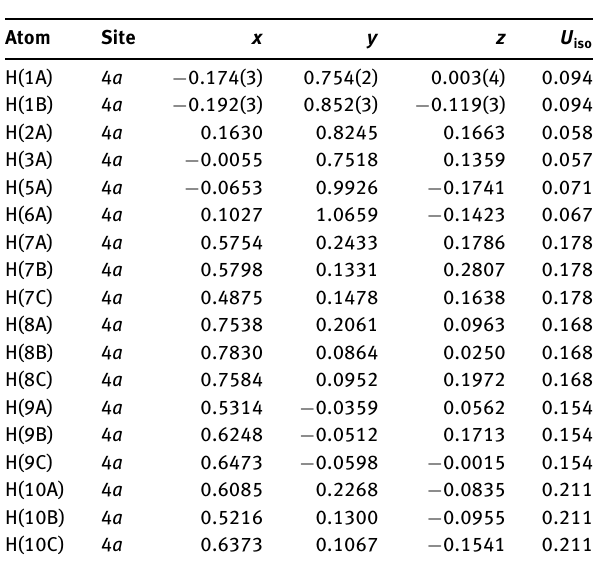
Table 2: Fractional atomic coordinates and isotropic or